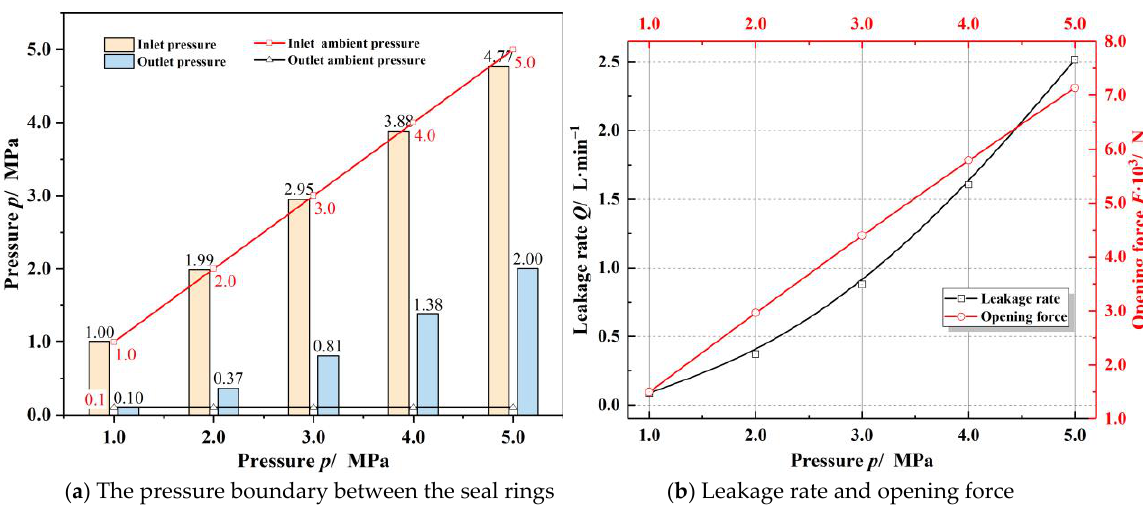
Figure 6. Influence of sealing pressure on the sealing performance ( h 0 = 3.0 μm, ω = 20,000 r·min −1 , T o = 200 K).